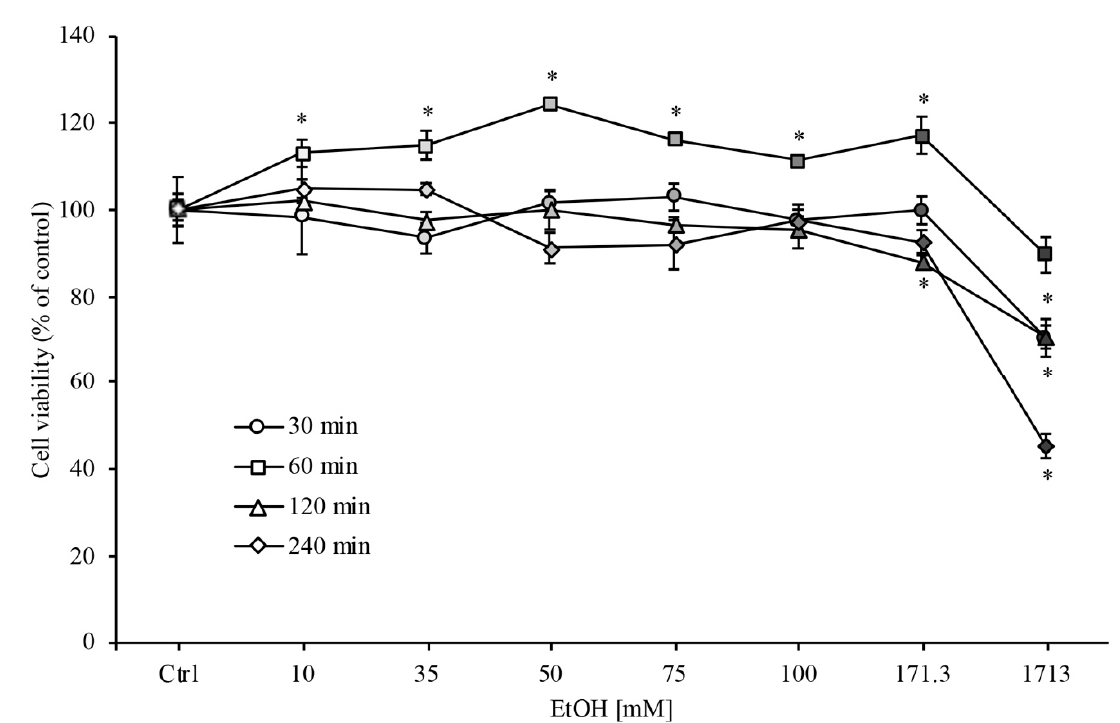
Figure 1. RBE4 cell viability assay during ethanol (EtOH) treatment. RBE4 cells were incubated with increasing EtOH concentrations (10–1731 mM) for 30 min, 1, 2 and 4 h. Cell viability, quantified by MTT (3-(4,5-di-methylthiozol-2-yl)-2,5-diphenyltetrazolium bromide) assay (570 nm wavelength absorbance), decreased significantly (* p < 0.05) only at the highest EtOH concentrations. Values are expressed in percentage of control (untreated cells) absorbance as the mean ± S.E.M. of three independent experiments in quintuplicate. Grayscale refers to the increasing EtOH concentration. * p < 0.05 vs. control (untreated cells).